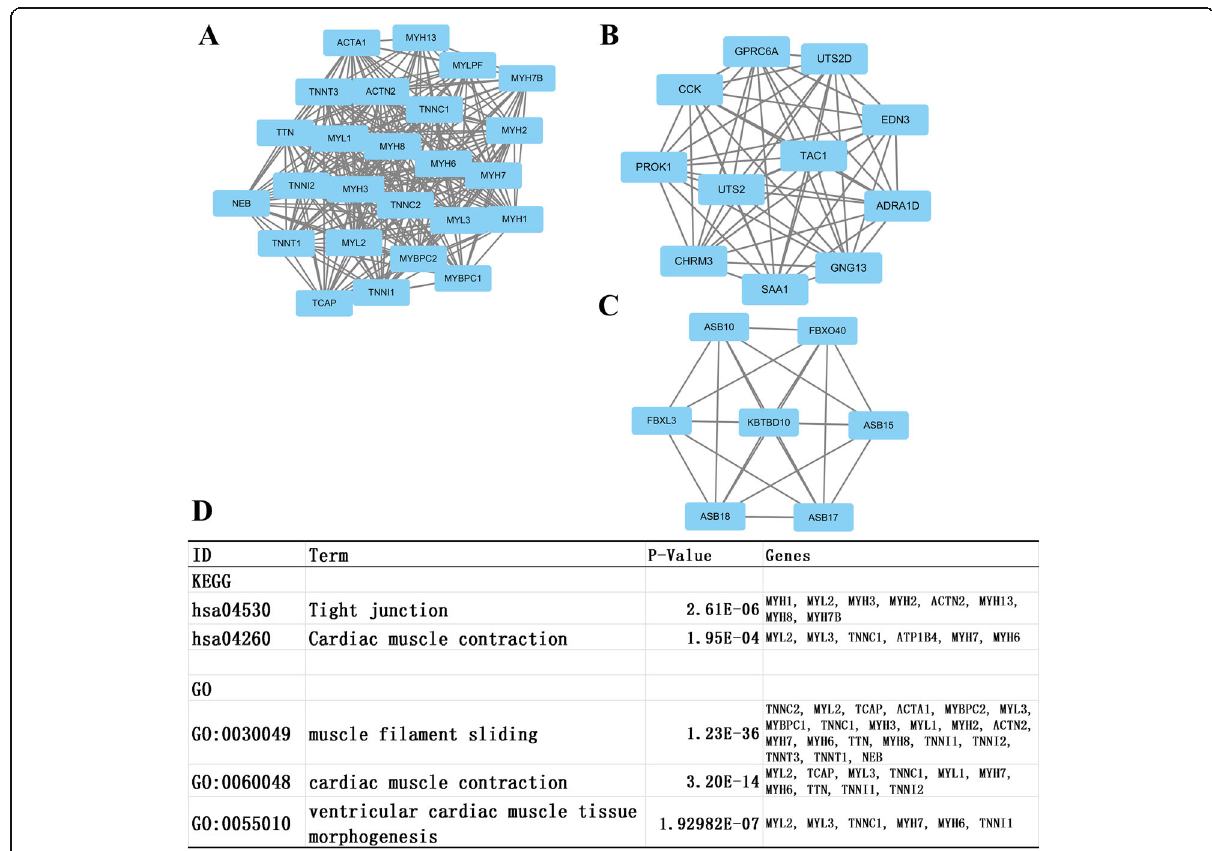
Fig. 6 Top three modules from the PPI network and the results of KEGG and GO analyses of module 1. A. Protein interaction network of module 1; B. Protein interaction network of module 2; C. Protein interaction network of module 3; D. GO and KEGG analyses of module